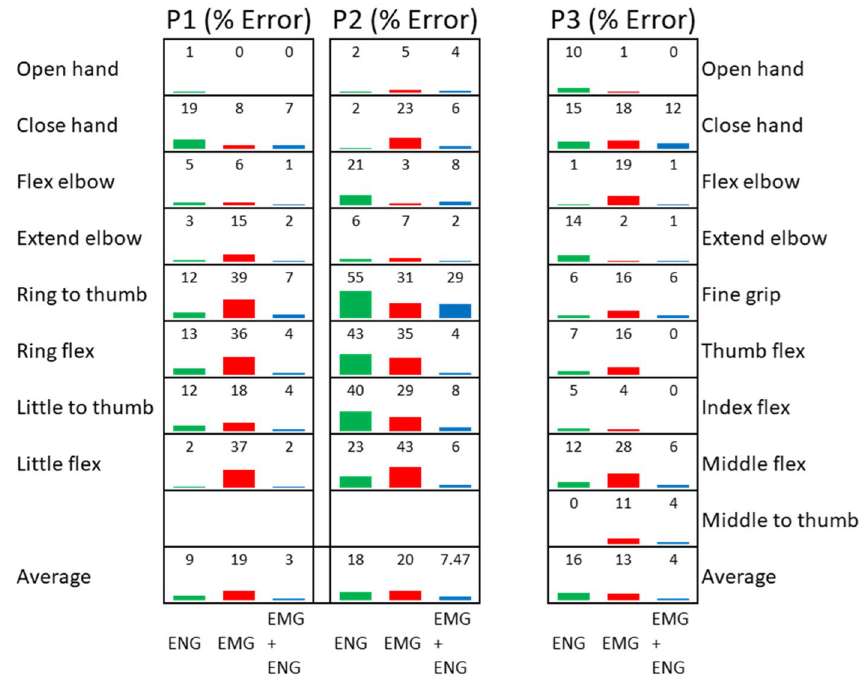
Figure 2. Offline decoding error on three participants (8 movements for P1–2 and 9 movements for P3) over the three different scenarios: (1) ENG alone, (2) EMG alone, and (3) EMG + ENG.